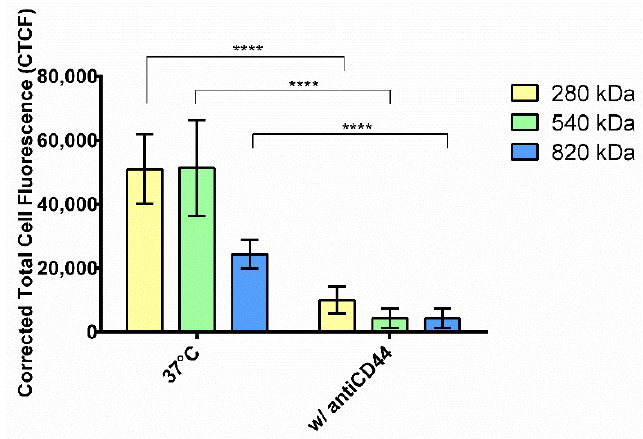
Figure 5. Energy dependence experiments: red fluorescent intensities of internalized HA/CS-RhB NPs after 90 min of incubation at 37 °C and 4 °C. HAs with different Mws were used: 280 kDa (yellow bar), 540 kDa (green bar) and 820 kDa (blue bar). Results are shown as mean ± SD. **** p value < 0.0001.